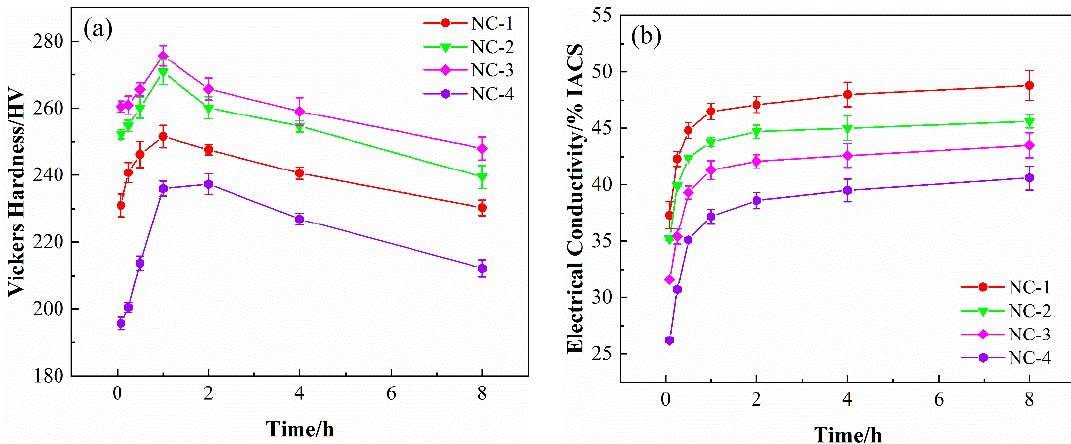
Figure 1. Variation curves of ( a ) hardness and ( b ) electrical conductivity of the tested alloys aged at 500 ◦ C for different times. Figure 2 presents a comparison of the mechanical properties of the tested alloys at the state of peak aging. The yield and tensile strengths are positively related to the hardness. Moreover, the yield strength of the four alloys exceeds 500 MPa, and the tensile strength exceeds 600 MPa. Among them, the yield and tensile strengths of the NC-3 alloy rank at the top, which are 644 and 720 MPa, respectively. When it comes to the elongation, it is negatively correlated with the strength of the alloys, which is 16.3%, 10.3%, 9.2% and 7.8%, respectively. Comparing the four alloys, the mechanical properties of the NC-3 alloy are generally better than those of the other alloys.